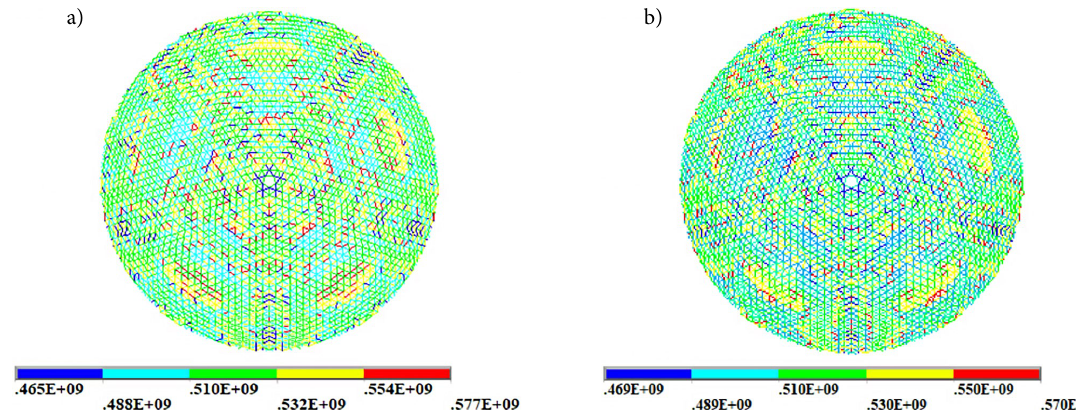
Figure 7. OCS stress nephogram obtained by different methods: a – Novel VFIFE method; b – Traditional finite element method